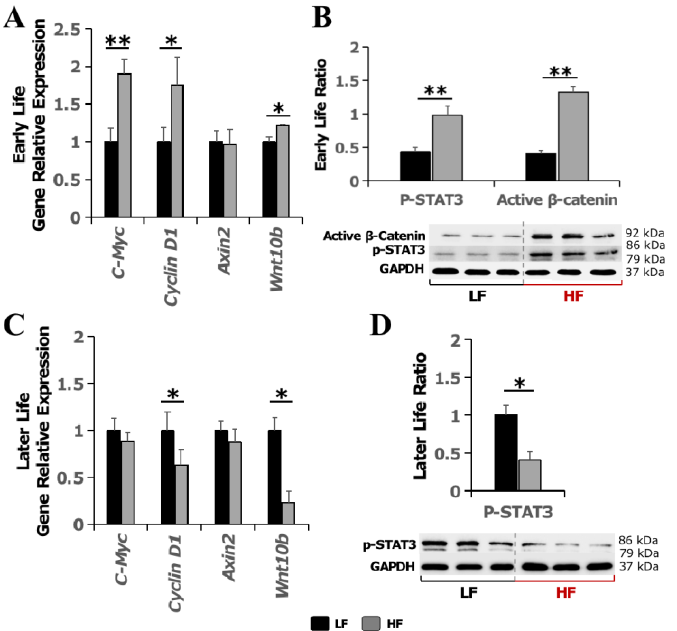
Figure 5. Effect of high-fat diet in early Life on Wnt signaling in inguinal mammary tissue later in life. ( A ) Transcriptional expression of Wnt signaling target genes and ( B ) Western blotting of phospho-STAT3 and active β -catenin in early life immediately after the 8 week experimental HF/LF diet feeding. ( C ) Transcriptional expression of Wnt signaling target genes and ( D ) Western blotting of phospho-STAT3 in later life after switching to the normal diet for an additional 12 weeks. Data are presented as mean ± SEM. n = 8 – 11 animals/group. *: p < 0.05; **: p < 0.01.